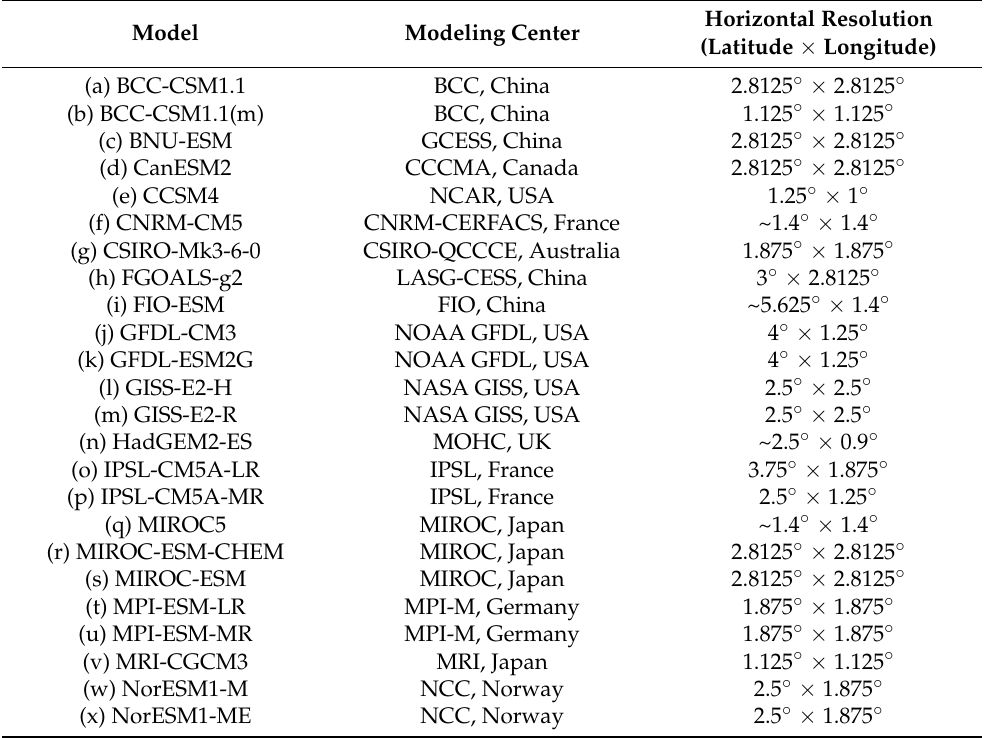
Table 1. Description of the Coupled Model Intercomparison Project Phase 5 (CMIP5) climate mod- els